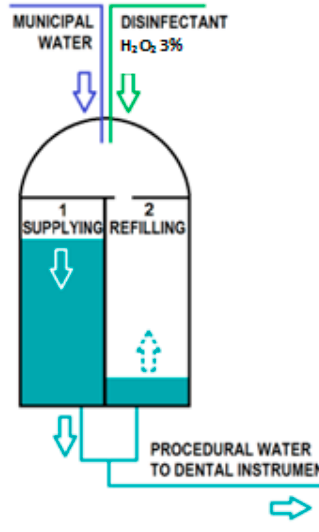
Figure 2. Technical structure and operation of the W.H.E. device.